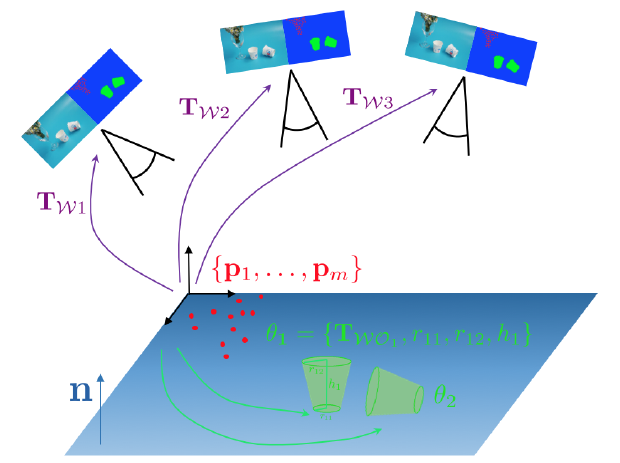
Figure 2. Visual SLAM scenario in which a camera observes a simple Desktop scene. The environment is represented as a hybrid composition of objects and primitive geometric elements (e.g., points and